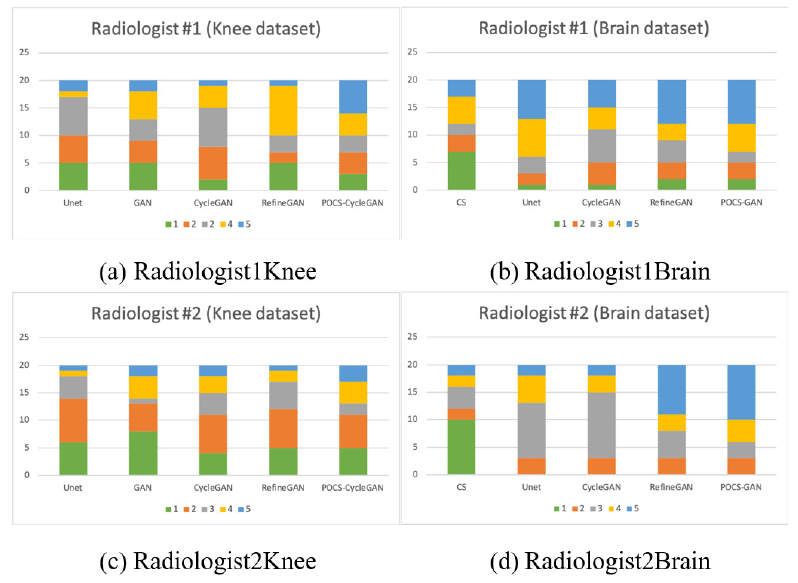
Figure 9. Comparison of radiologic scores between different methods over 20 subjects’ brain and knee MR images. Radiologic scores are displayed with five different colors. Vertical axis indicates the number of subjects for each radiologic score.